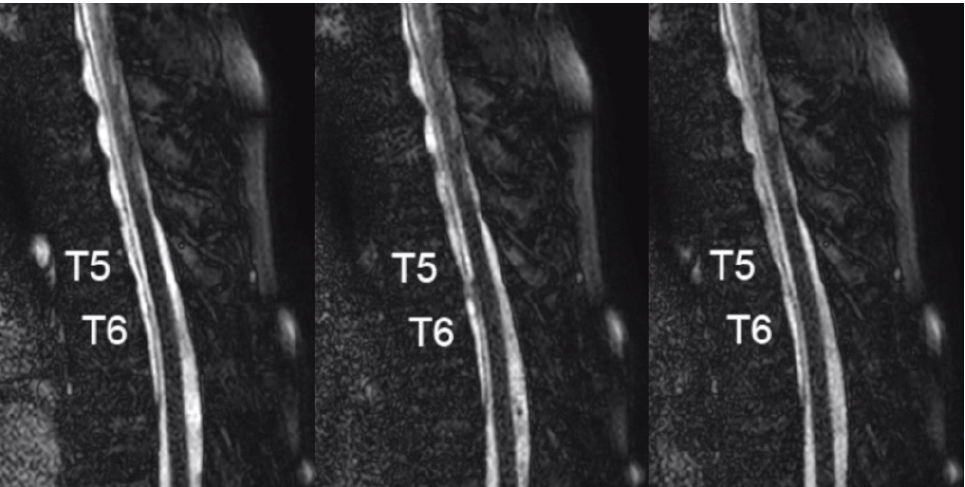
Figure 3. Images achieved by a dynamic improved motion-sensitized driven-equilibrium steady-state free precession (dynamic iMSDE SSFP) MRI sequence reveal an irregular flow of CSF through the dura at the T5–T6 level in the middle panel, confirming the position of the dural defect.